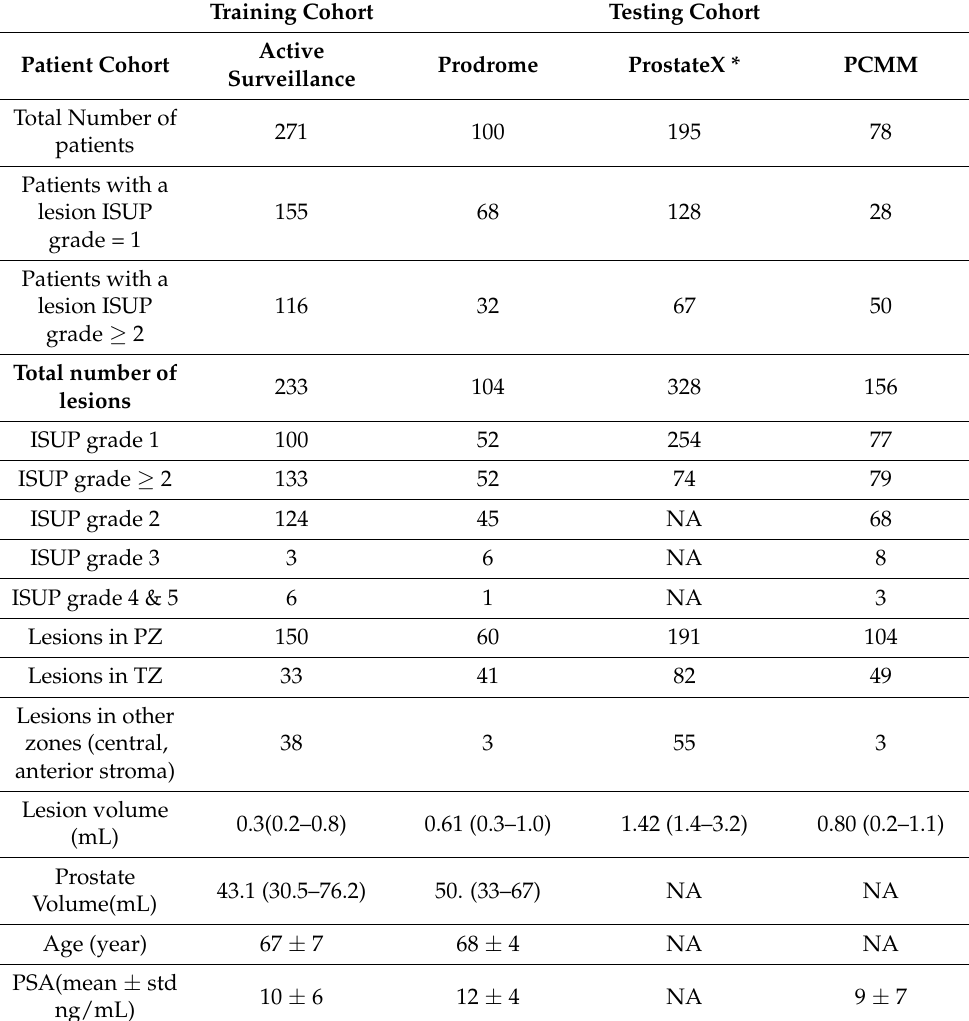
Table 1. Clinical characteristics of the patients of the four cohorts (Active Surveillance, Prodrome, ProstateX and PCMM) included in this study. Tumorr volume values are presented as median (interquartile range). PZ : peripheral zone. TZ : transition zone. ISUP : International Society of Urological Pathology. GSA: Gleason Score. PSA : Prostate Specific Antigen. NA : not available. ( * ) The ISUP grade per lesion was not available for ProstateX challenge, the ground truth provided